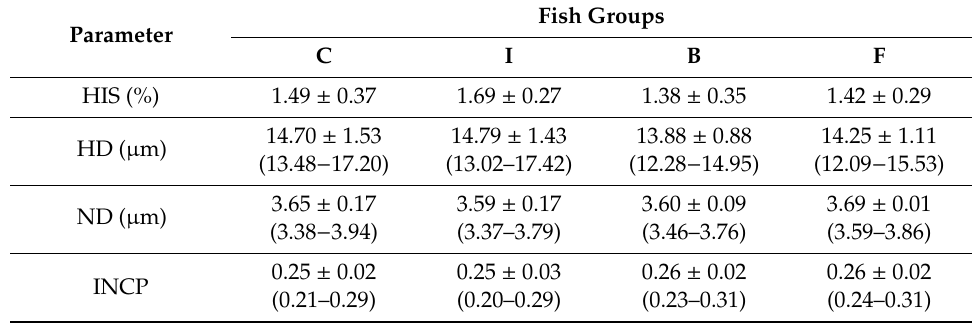
Table 4. Morphological and histological indicators of pikeperch liver (mean value ± SD, n = 8, p ≤